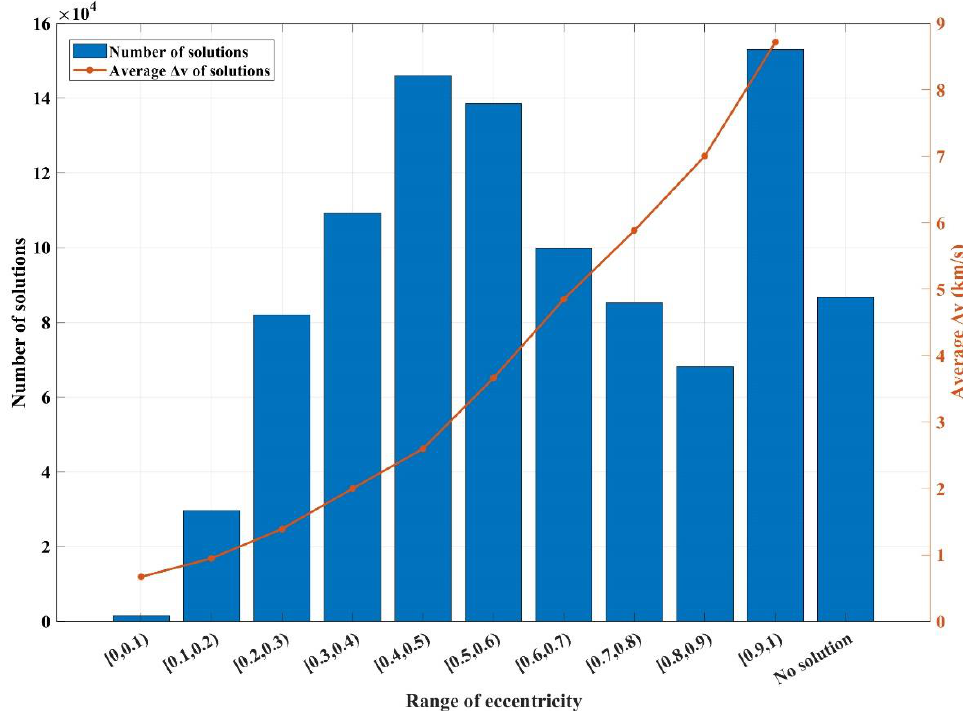
Figure 10. The eccentricity and average v of the solutions.